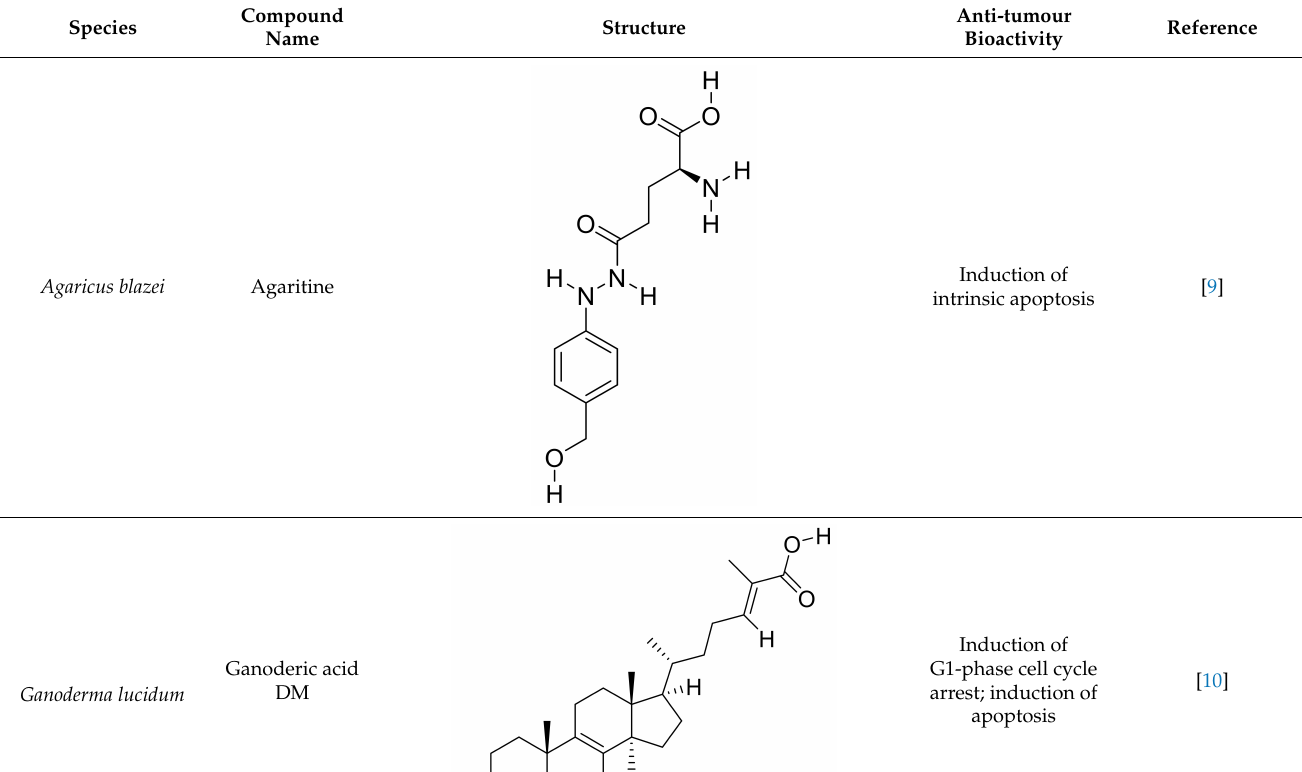
Table 2. The structure and anti-cancer action of bioactive compounds isolated from mycomedicines that are included in this review.